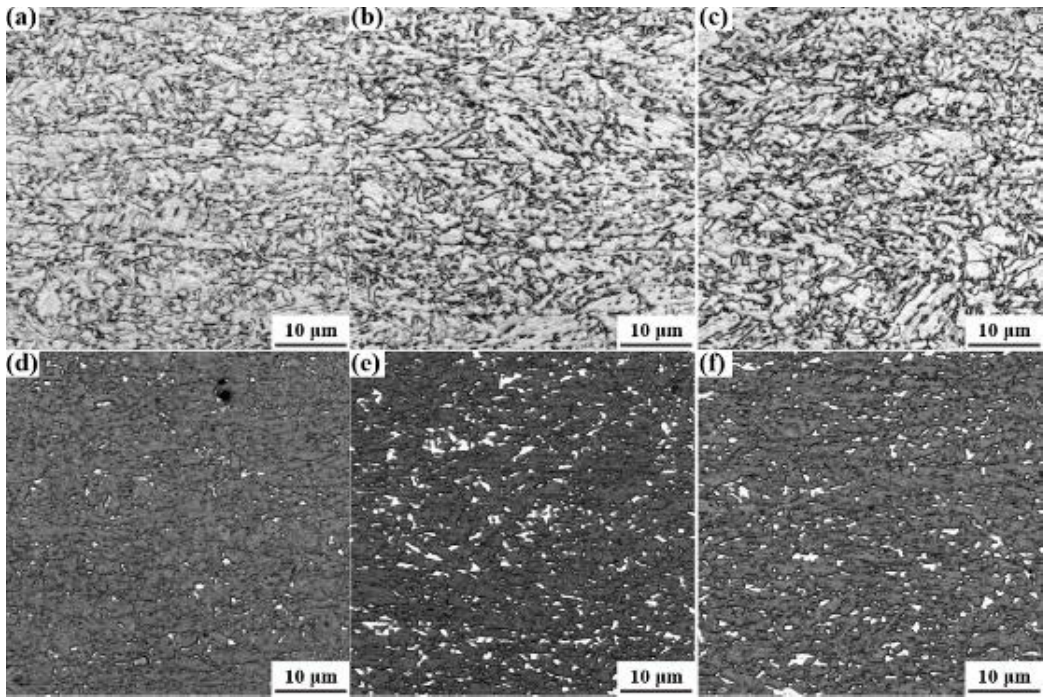
Figure 1. OM micrograph of the microstructure of the best HER ( a ), the worst HER ( b ), and the second ‐ best HER ( c ) and the corresponding M/A continents distribution map ( d – f ) to ( a – c ), respectively.